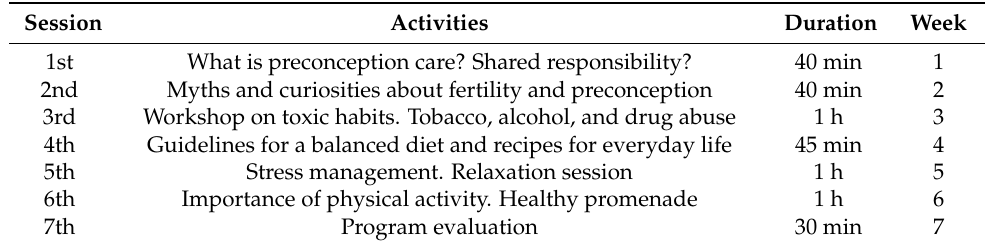
Table 1. Chronogram of the